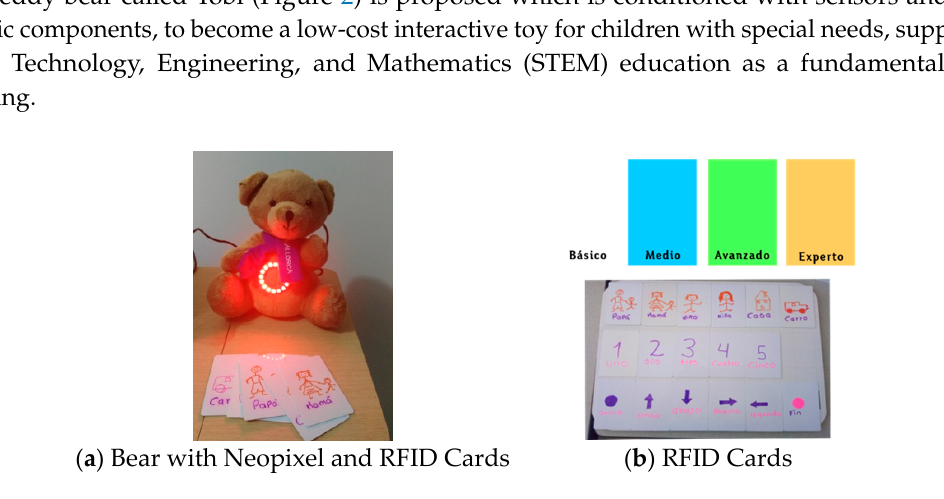
Figure 2. Interactive toy called Tobi using Science, Technology, Engineering, and Mathematics (STEM) methodology. In [28].